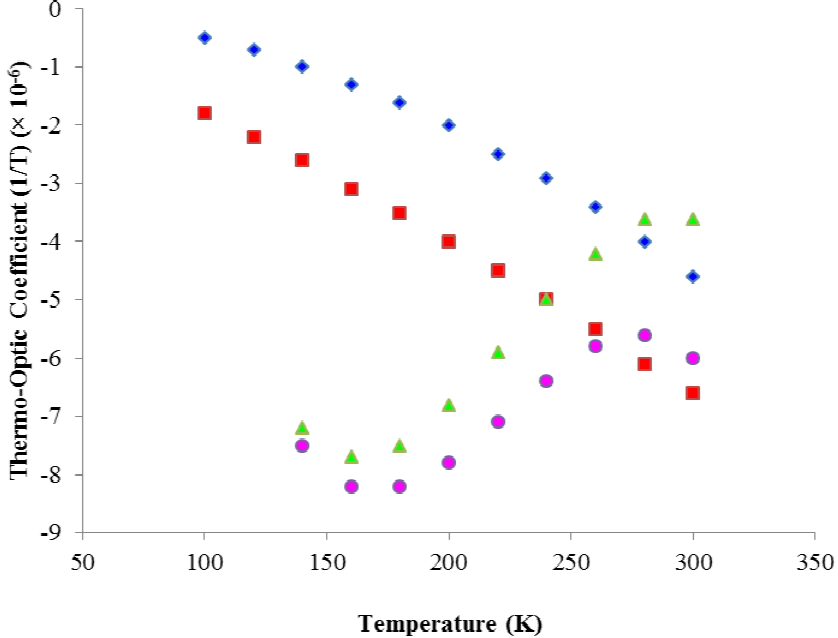
Figure 29. Thermo-optic coefficient as a function of absolute temperature for YLF a (blue) and c (red) axes [29] and LuLF a (green) and c (pink) axes [29], measured at a wavelength of 1064 nm.